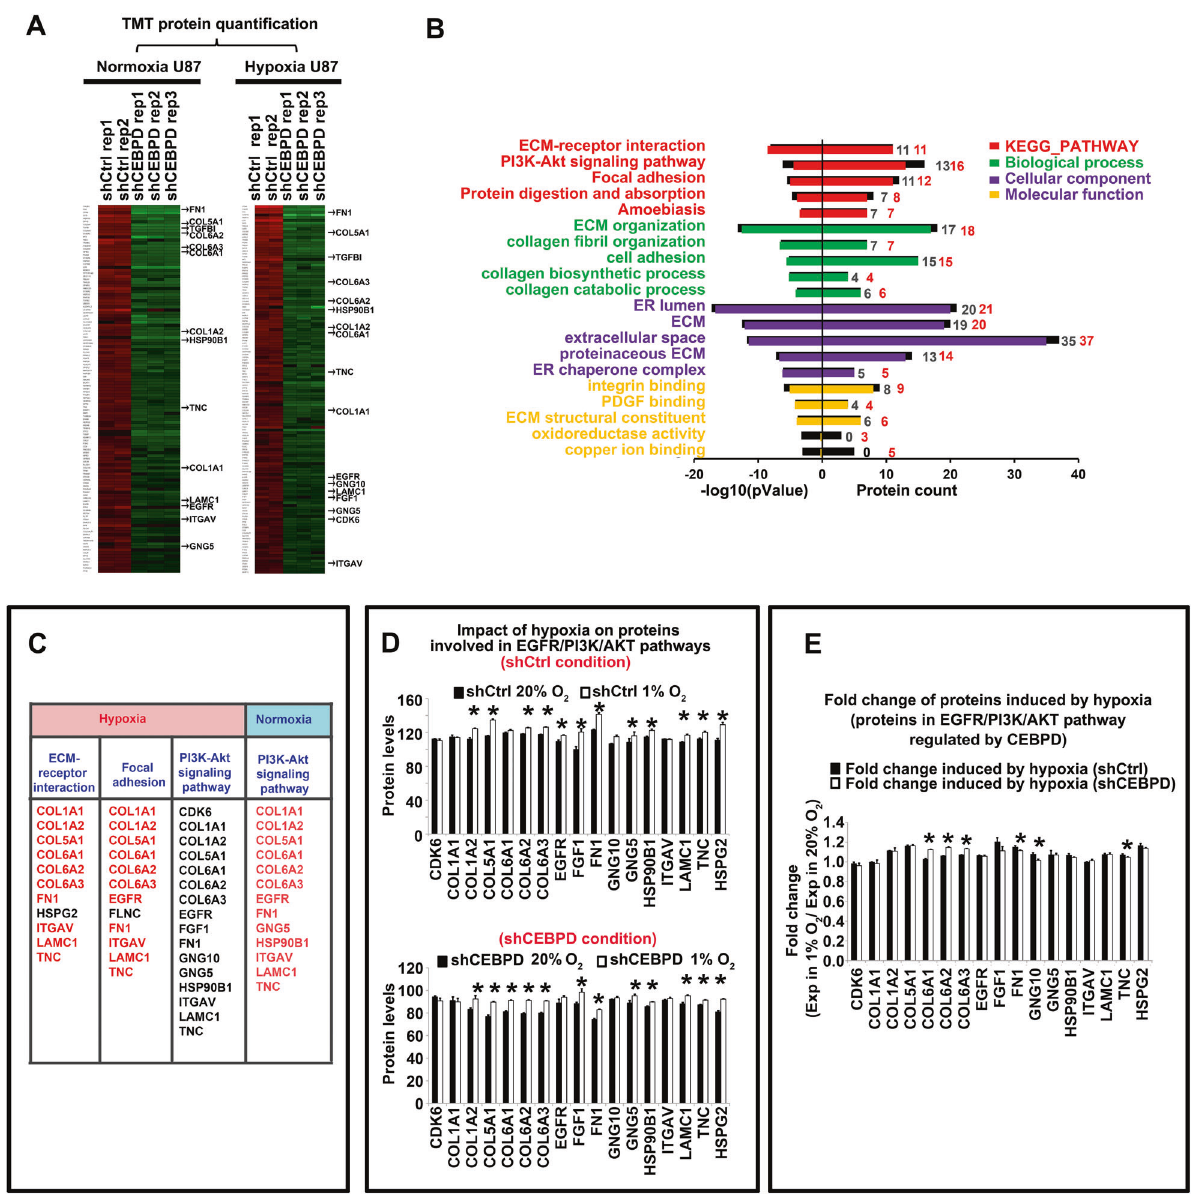
Fig. 5 CEBPD-regulated proteins in both normoxia and hypoxia conditions. A TMT quantitative proteomic data, showing heatmap of protein levels in shCEBPD KD and shCtrl U87 cells, in both normoxia (20% O 2 ) and hypoxia (1% O 2 ) conditions. Proteins that are signi fi cantly down-regulated at least 1.2-folds after shCEBPD KD were chosen as the CEBPD-regulated proteins. The proteins were sorted in descending order from top to bottom according to their folds changes. B KEGG pathway analysis and Gene Ontology (GO) analysis of CEBPD positively regulated proteins in both normoxia and hypoxia conditions in U87 cells. Analyzed GO Categories include Biological process (BP), Cellular component (CM), and Molecular function (MF). The colored bars represent the − log10( p value) (left panel) and count of protein (right panel) for each enriched items for CEBPD-regulated protein in normoxia. The black bars, which are covered by the colored bars, represent the corresponding values for CEBPD-regulated proteins in hypoxia. The black parts that are not covered by the colored ones indicated that, for the speci fi c item, the value of the item has a greater value in hypoxia condition than in normoxia condition. The black and red integers in the right panel indicate counts of proteins regulated by CEBPD in normoxia and hypoxia conditions, respectively. C Detailed proteins that are belong to the key KEGG pathways affected by CEBPD knockdown in both normoxia and hypoxia conditions. Proteins labeled with red are those which are also belong to the PI3K/Akt signal pathway. D Quantitative analysis of hypoxia impact on the protein levels that are belong to the key KEGG pathways, in shCtrl (up panel) or shCEBPD KD (bottom panel) conditions. * p < 0.05, compared with normoxia (20% O 2 ) group. E Fold changes of hypoxia induced protein levels of the CEBPD-regulated genes in shCtrl and shCEBPD KD groups. * p < 0.05 compared with the shCtrl group. Repeated data for each group were obtained by calculating the ratio of each hypoxia data to the averaged value of normoxia analysis revealed that CEBPD is positively correlated with the CEBPD remarkably affected the EGFR/PI3K pathway activity expression level of CEBPD target genes that are involved in the under hypoxic condition in GBM patient samples EGFR/PI3K/AKT pathway (Fig. 7A), even in each GBM subtype Whether the regulatory effects of CEBPD on EGFR/PI3K pathway (Proneural, Neural, Classical, and Mesenchymal; Fig. 7A, right panel). would be hold in GBM patients need to be considered. Correlation